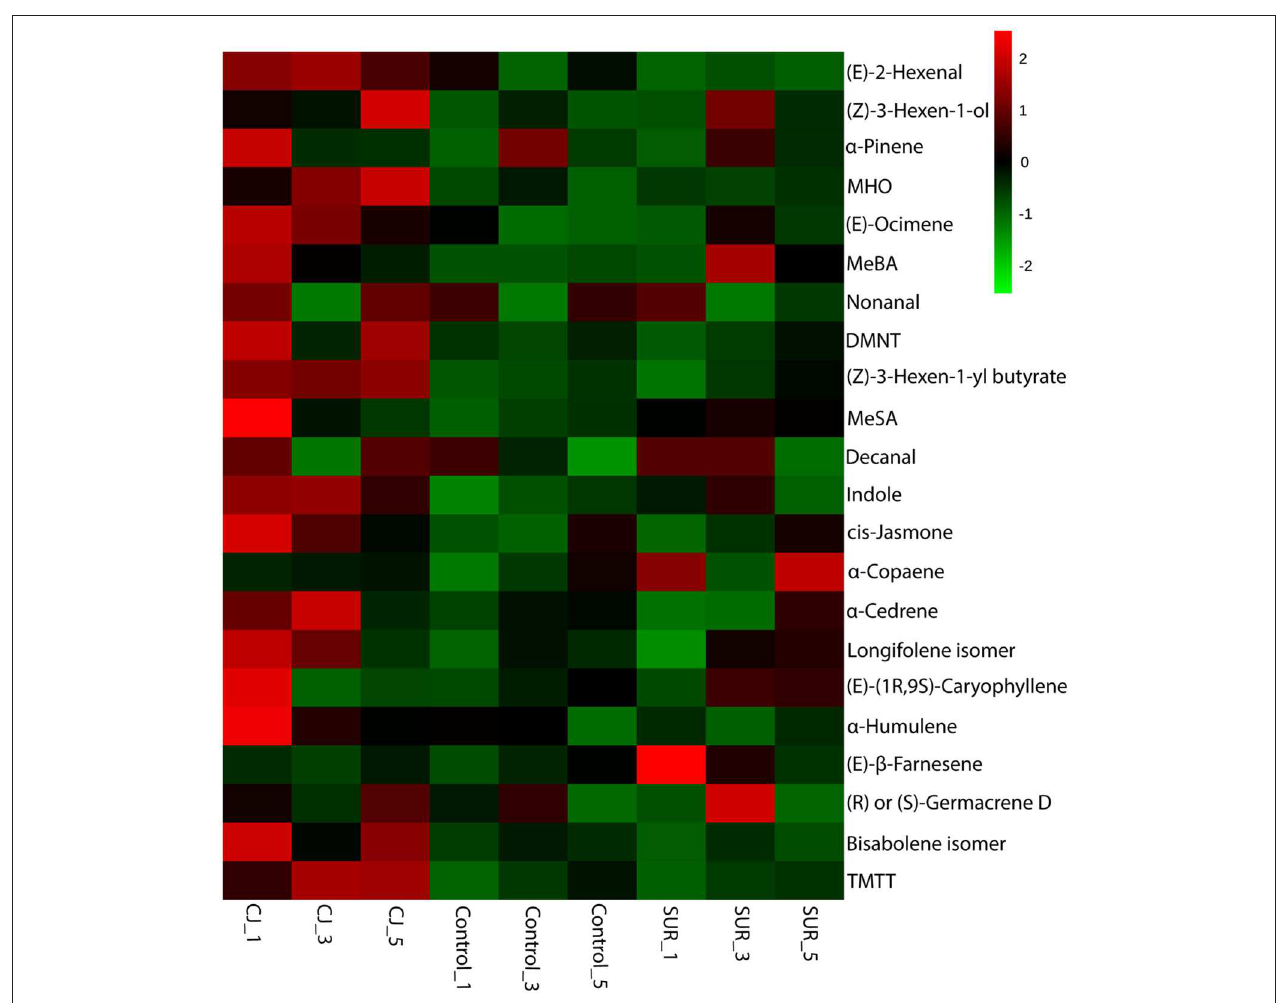
FIGURE 3 | Hierarchical cluster of the volatile profiles emitted by potato plants that were treated with cis -jasmone (CJ) or surfactant (SUR) in comparison to untreated plants (Control). Cube root transformed values of biological replicates ( n = 3) are represented as a heatmap according to the scale in which red corresponds to higher VOCs emission whereas green denotes lower VOCs emission. The heatmap was constructed using the average of three biological replicates in each collection point (i.e., 24, 72, and 120h). The sample/VOC grouping is based on Ward clustering algorithm of the Euclidean distance measure for the differentially emitted VOCs detected by ANOVA (Tukey’s post-hoc tests, P < 0.05). Quantitative data are shown in Table 2